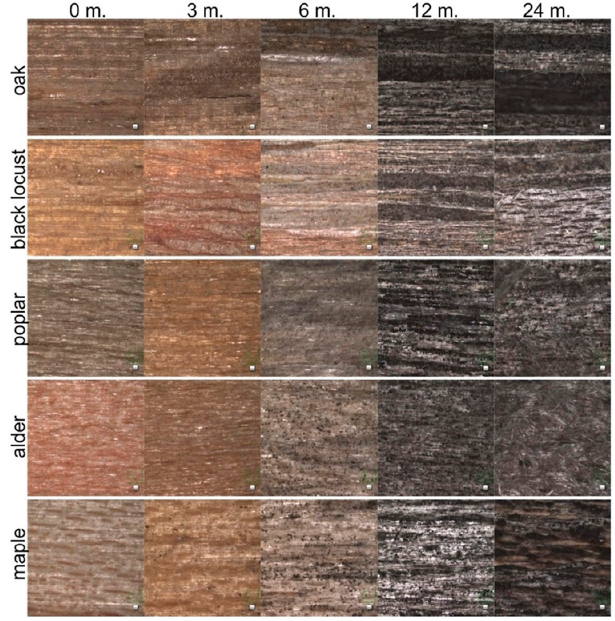
Figure 7. Confocal microscopy of samples during exposure to natural weathering (each scan corresponds to an area of 2.5 × 2.5 mm).